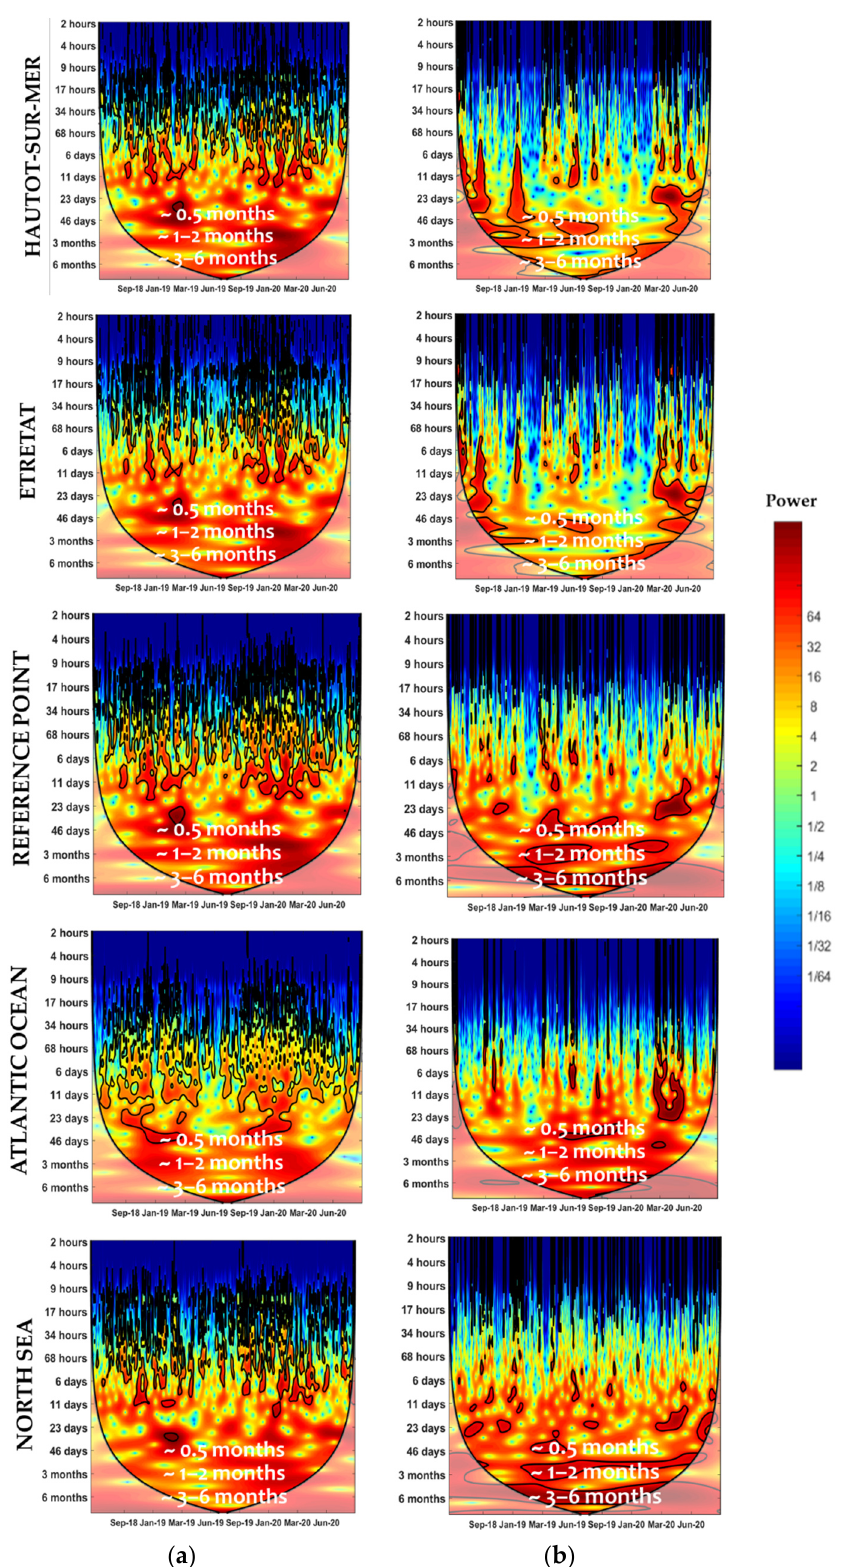
Figure 6. Continuous Wavelet Transform (CWT) of H s ( a ) and θ ( b ) at deep waters in the North Sea, the Atlantic Ocean, the Reference point (depth = 28 m), close to Etretat (depth = 13.4 m) and Hautot-sur-Mer (depth = 13 m).